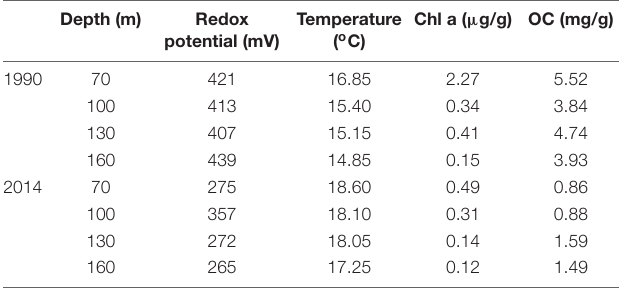
TABLE 1 | Historical and recent data on the environmental conditions prevailed in the top layer of the sediment during the 1990 and 2014 samplings. Depth (m) Redox Temperature potential (mV) ( o